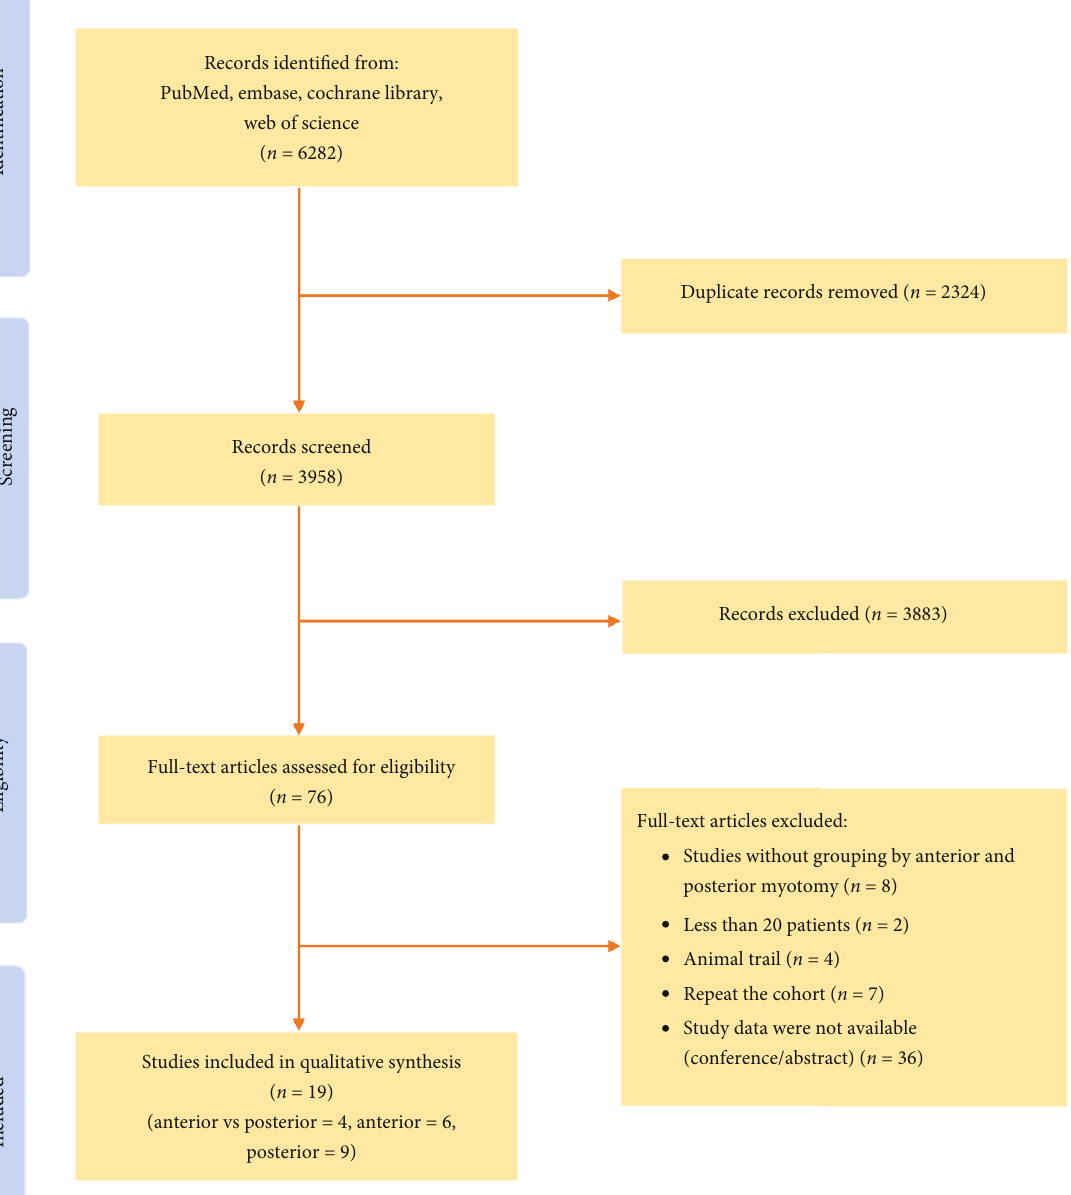
Figure 1: Study selection fl ow